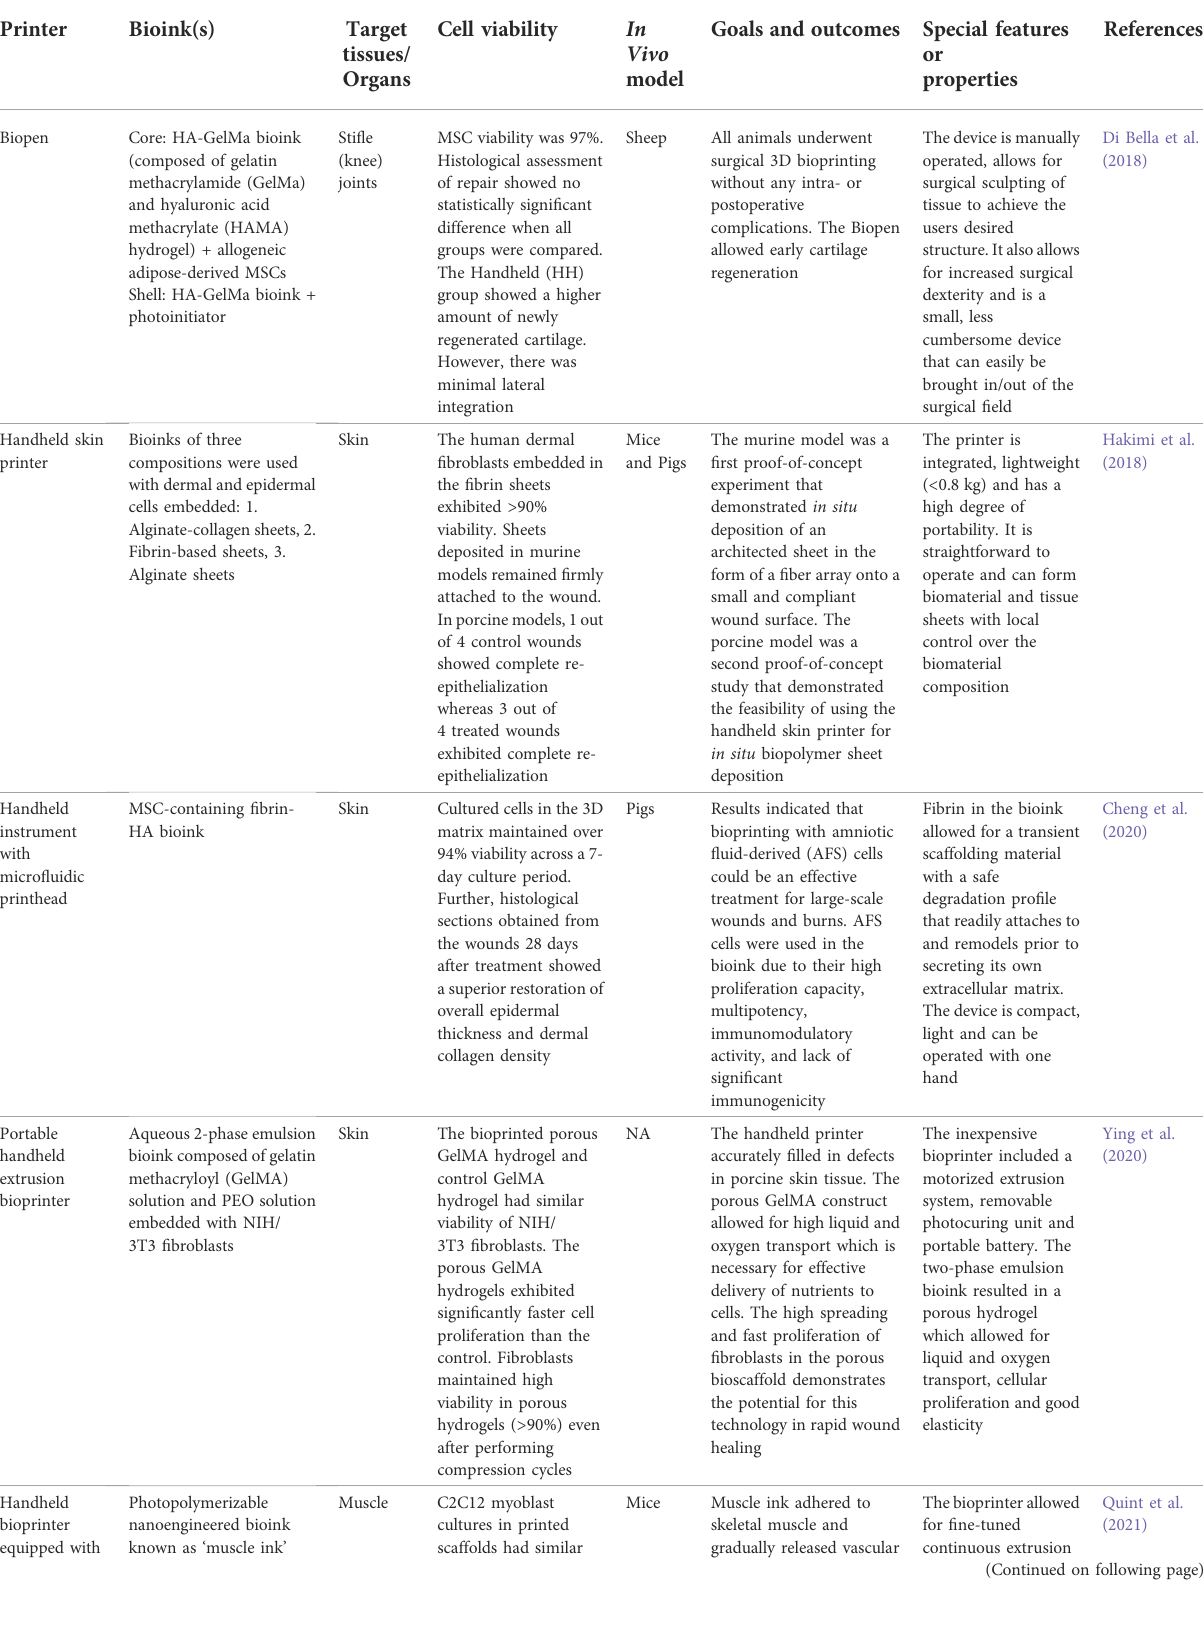
TABLE 2 In situ 3D bioprinting — hand-held